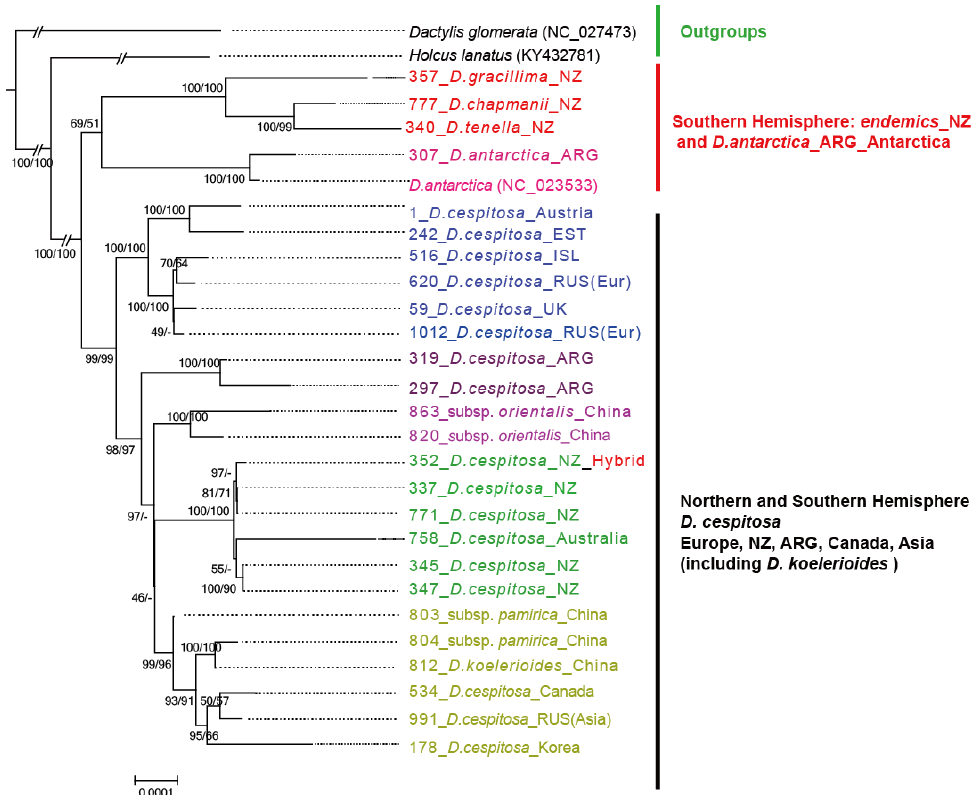
Figure 4. Maximum Likelihood phylogenetic tree based on whole plastid genome data. Both bootstrap of ML and Maximum Parsimony phylogenetic tree are shown on the branch of the ML tree. Both Holcus lanatus and Dactylis glomerata are used as outgroups. NZ = New Zealand, ARG = Argentina, EST = Estonia, ISL = Iceland, UK = United Kingdom, RUS = Russia, Eur = Europe.